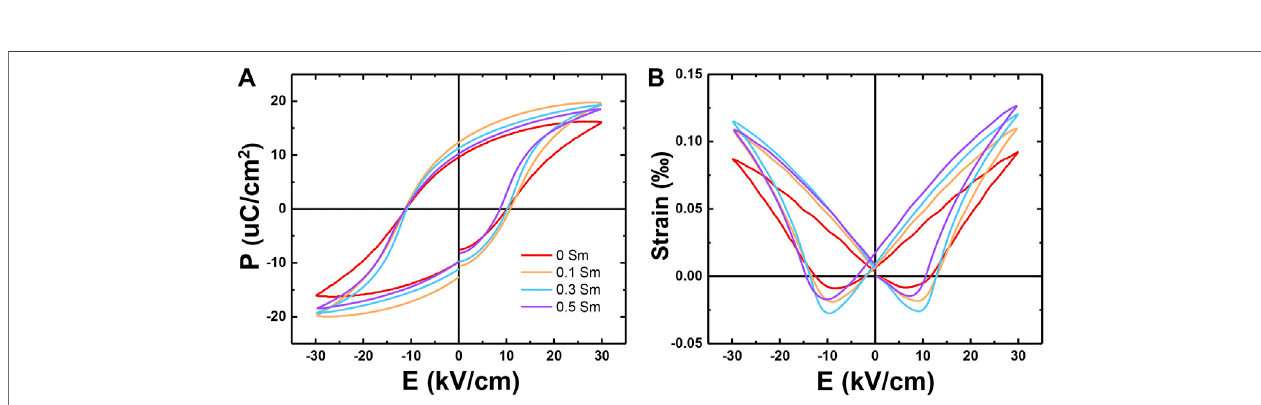
FIGURE1| XRD patterns ofun-doped (Quan et al.,2018) and Sm 3+ -modi fi ed KNLN-BZ-BNT ceramics. (A) 2 θ isbetween10 and 60 ° , and (B) 2 θ isbetween 44.5 and 46 ° .